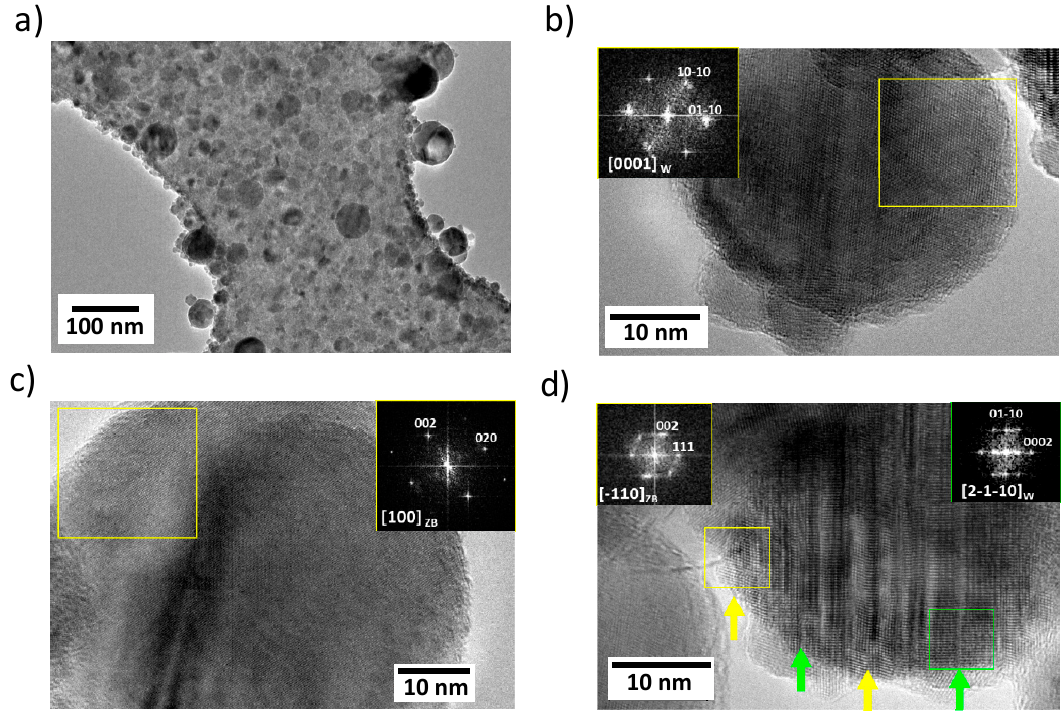
Figure 4. Transmission Electron Microscopy (TEM) images of the nanoparticles synthesized on polymer-coated TEM grids found in di ff erent PLD deposits. ( a ) shows an overview of one of the deposits where a large dispersion in the particle size can be observed. The deposit was obtained by DP irradiation at an interpulse delay of 10 ps and 2 × 106 double pulse sequences. In ( b – d ) high magnification images allows the identification of the crystalline phases in single nanoparticles obtained by DP irradiation at an interpulse delay of 300 ps and 2 × 106 double pulse sequences. ( b – d ) show TEM images together with the corresponding FFT patterns obtained (insets) in the areas highlighted with the coloured squares. In ( b ) the nanoparticle is identified as wurtzite along the [0001] W zone axis. In ( c ) the nanoparticle is oriented along the [100] ZB zone axis of cubic zinc blende. The several crystalline planes observed correspond to the wurtzite structure of ZnS. ( d ) shows the intergrowth of the two main polytypes of ZnS, zinc blende and wurtzite, within the same nanoparticle.